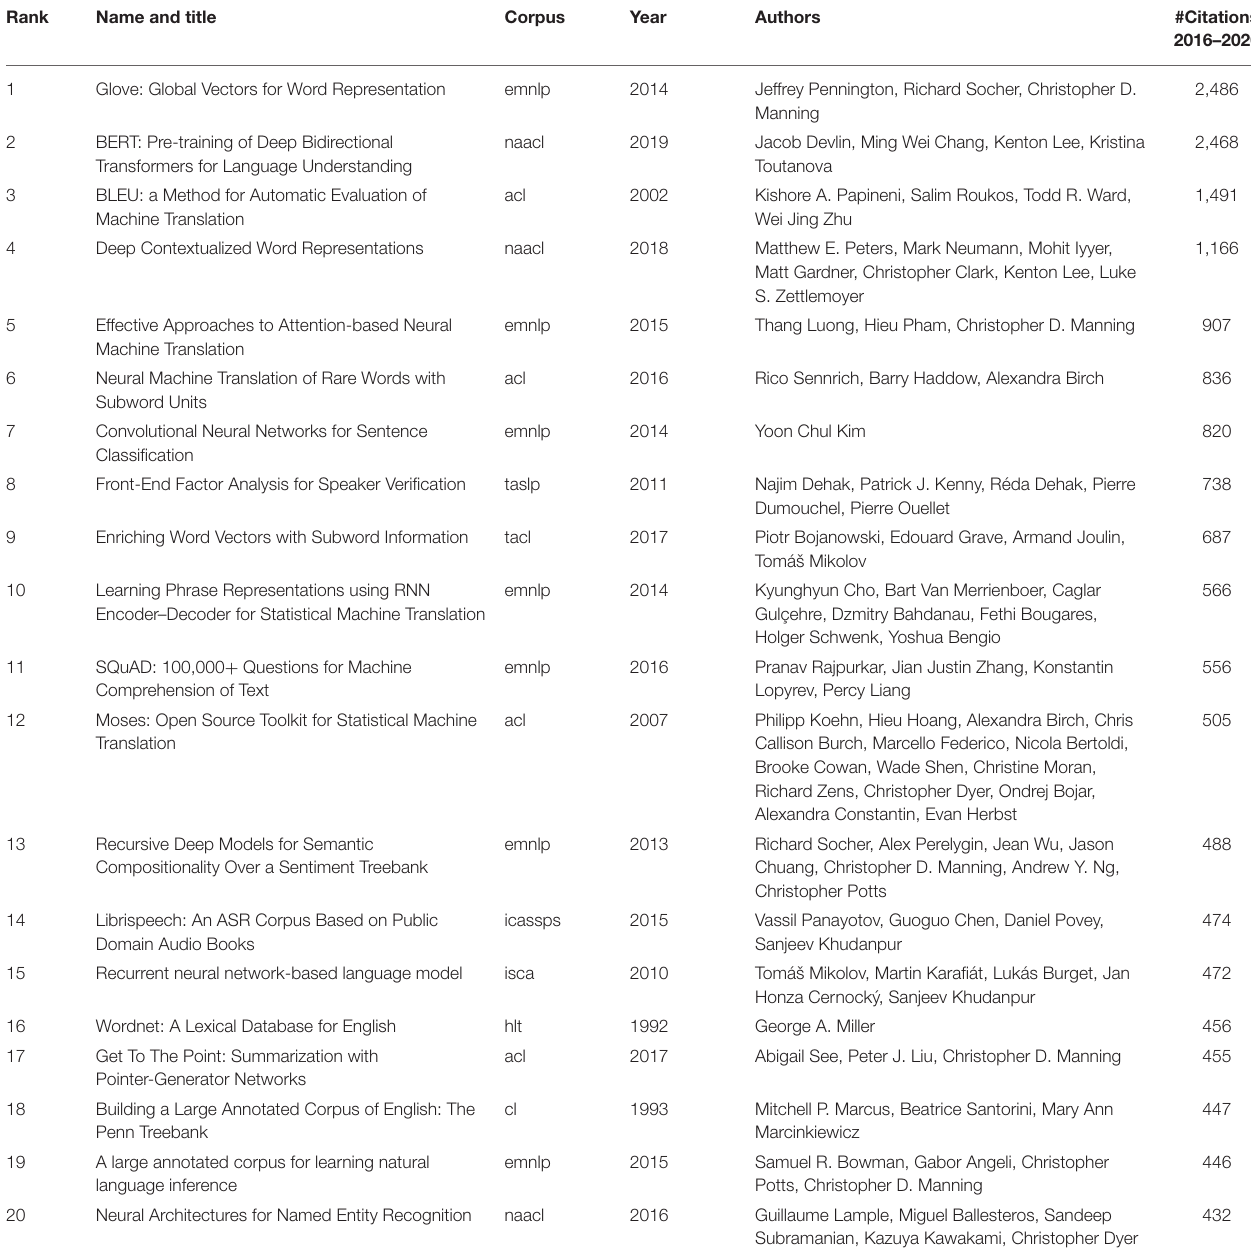
TABLE 19 | The number of 20 most cited papers for the past 5 years (2016–2020).